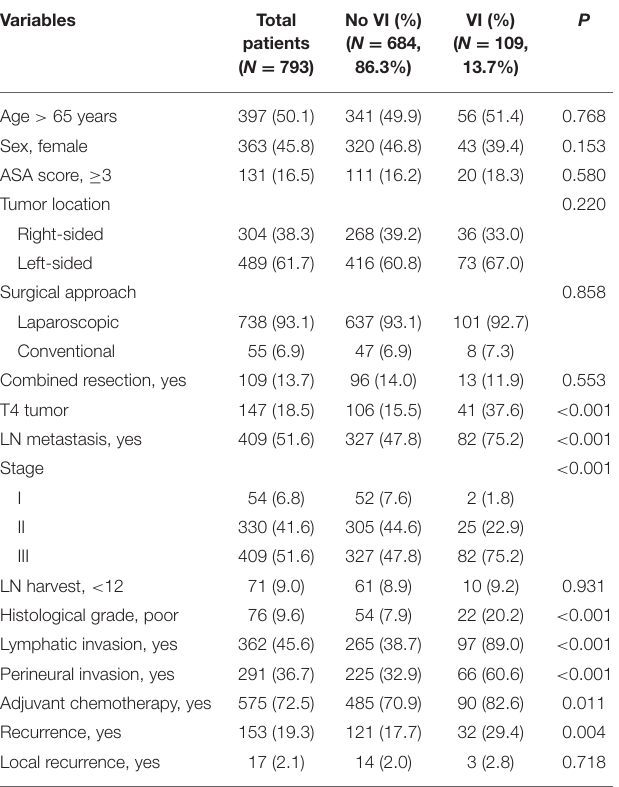
TABLE 1 | Patient’s clinico-pathological characteristics according to the presence of vascular invasion (VI).